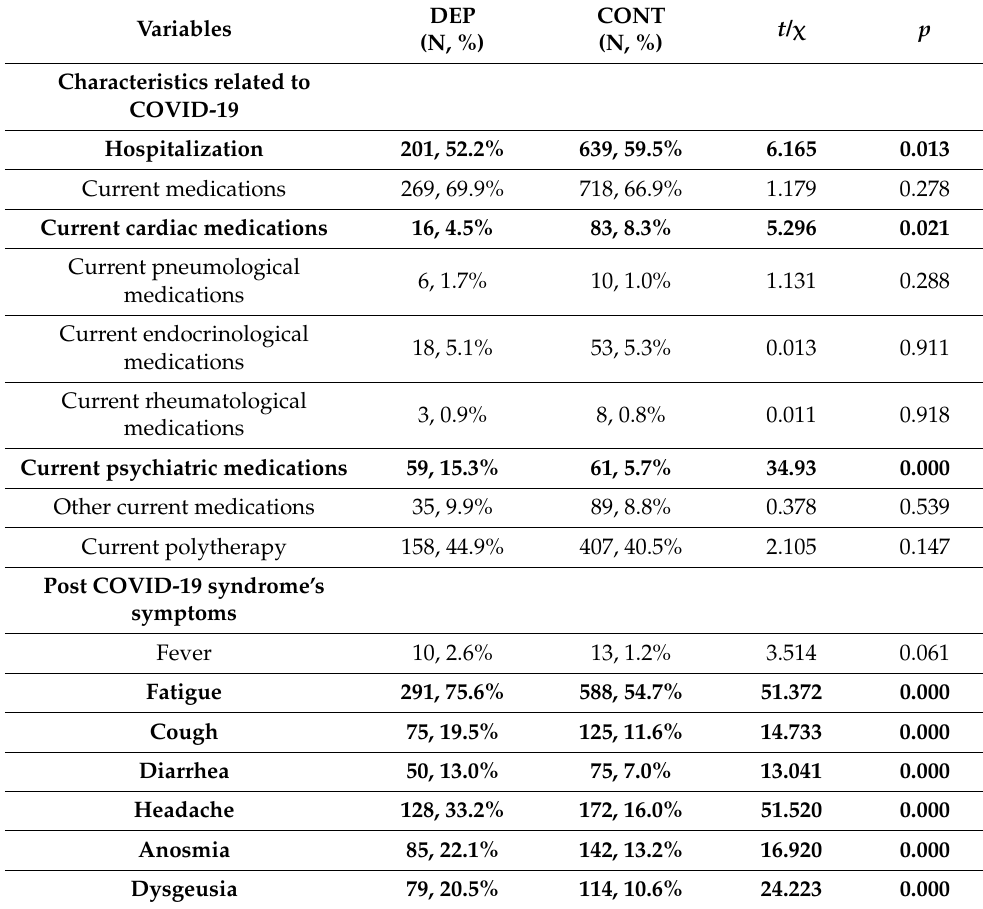
Table 2. Differences in COVID-19 related characteristics and post-COVID-19 syndrome’s